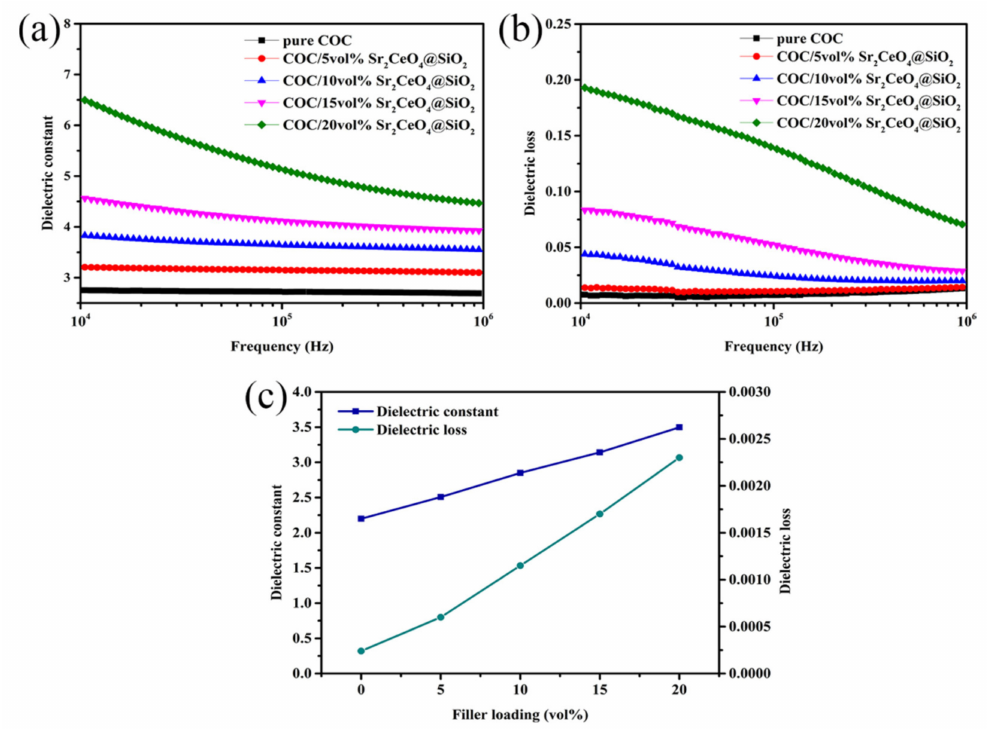
Figure 5. ( a , b ) The dielectric constant and dielectric loss of COC/Sr 2 CeO 4 @SiO 2 composites in range of 10 4 –10 6 Hz; ( c ) the dielectric constant and dielectric loss of COC/Sr 2 CeO 4 @SiO 2 composites under 10 GHz.